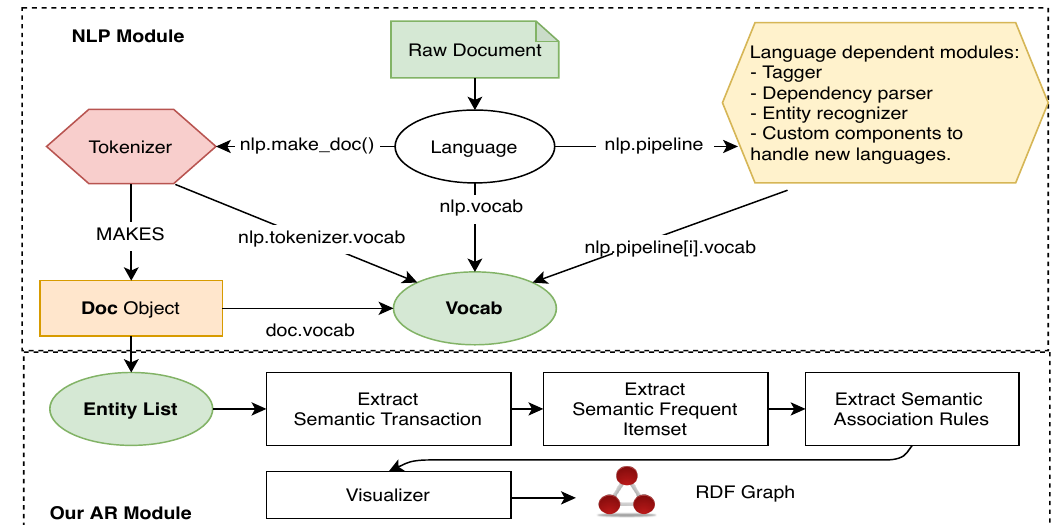
Figure 3. Mining semantic association rules from text data using Named Entity Recognition (NER) with the NLP Module built on top of SpaCy’s architecture. The flexible architecture of SpaCy allows WINFRA to support multiple languages including the ability to add custom components such as custom word embeddings, to handle new terms on social